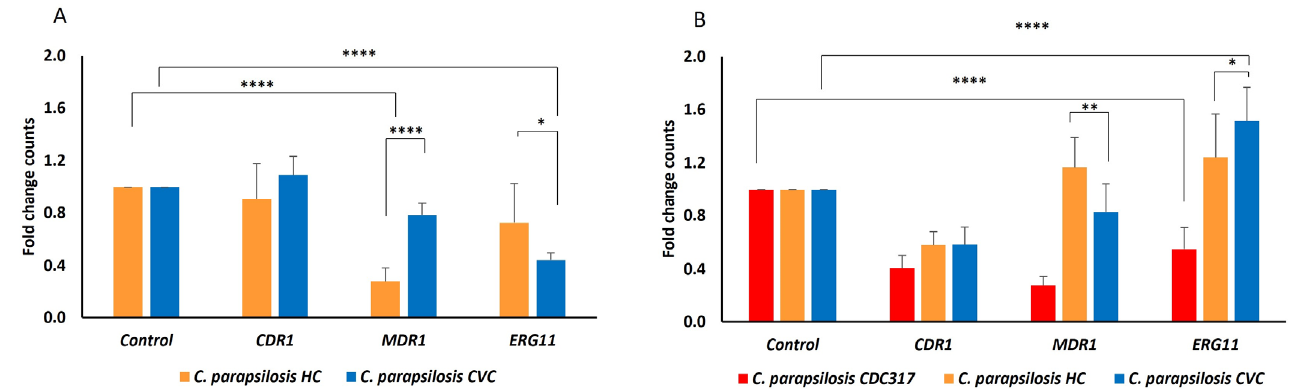
Figure 1. Relative fold-change in gene expression of C. parapsilosis . ( A ) Chart represents relative changes in expression of the CDR1 , MDR1 and ERG11 genes in isolates of C. parapsilosis HC and CVC compared to standard C. parapsilosis CDC317 that was set up as a control and normalized to the value of 1. ( B ) Chart represents relative changes in expression of the CDR1 , MDR1 and ERG11 genes in CDC317 strain, isolates of HC and CVC after 5 h incubation in the presence of sub-inhibitory concertation of FLU (2 µg/mL) compared to non-treated samples of corresponding isolates set to 1. A p < 0.05 (*) was considered statistically significant; p < 0.01 (**) highly significant; p < 0.0001 (****) highly extremely significant.